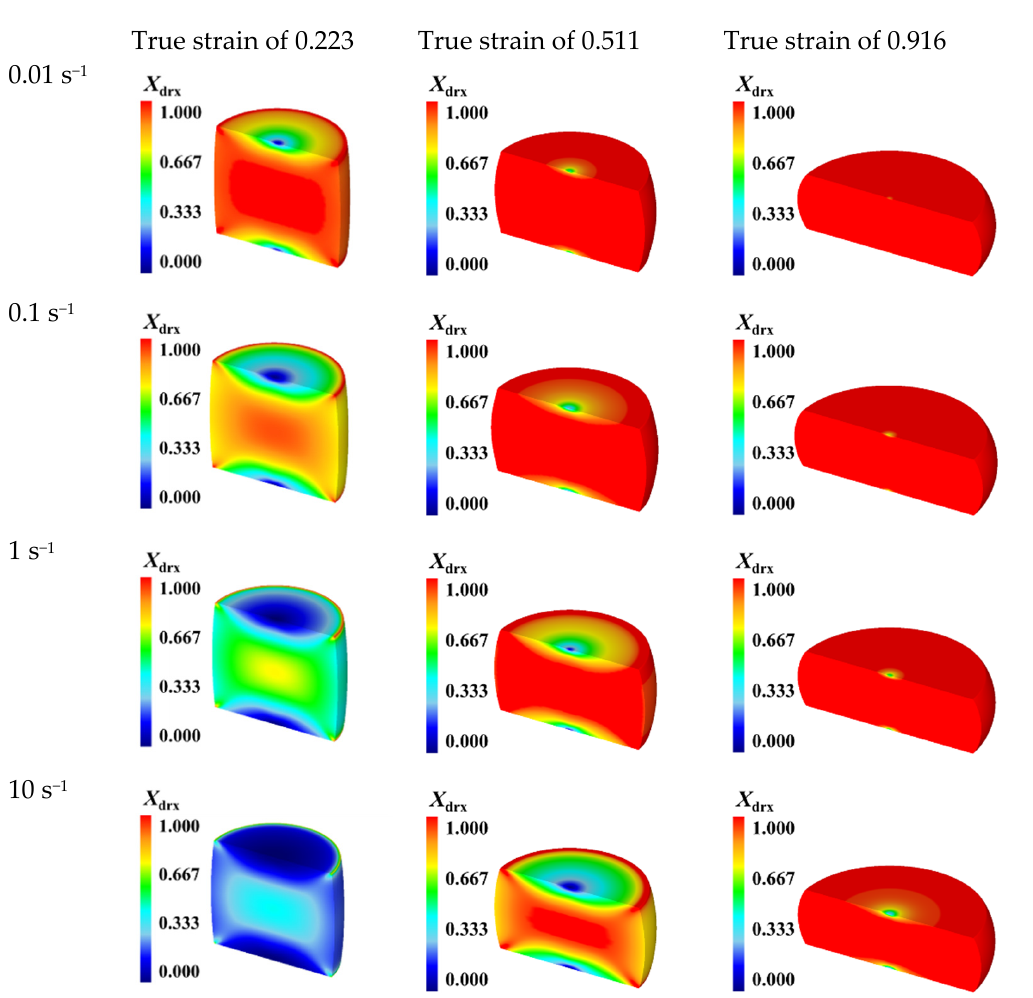
Figure 17. DRX volume fraction distributions of the specimens compressed to different true strains under the temperature of 1303 K and different strain rates of 0.01–10 s − 1 .